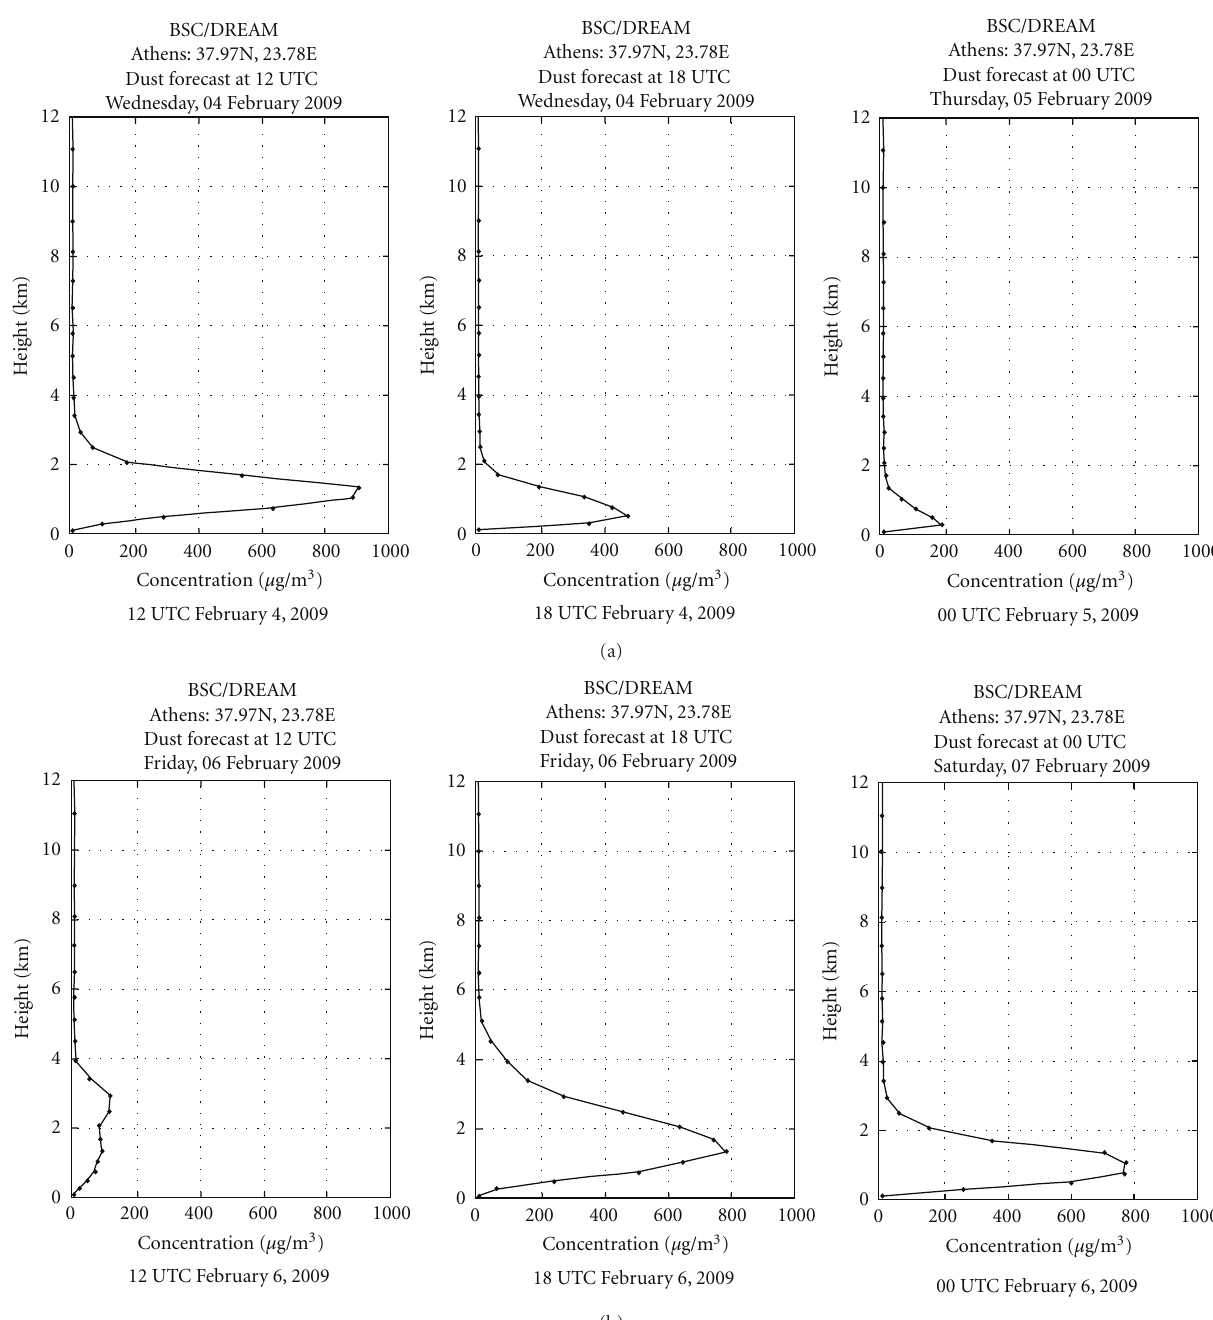
Figure 8: DREAM 6-hour vertical profile of dust forecast for February 4, 2009 (a) and February 6, 2009 (b).